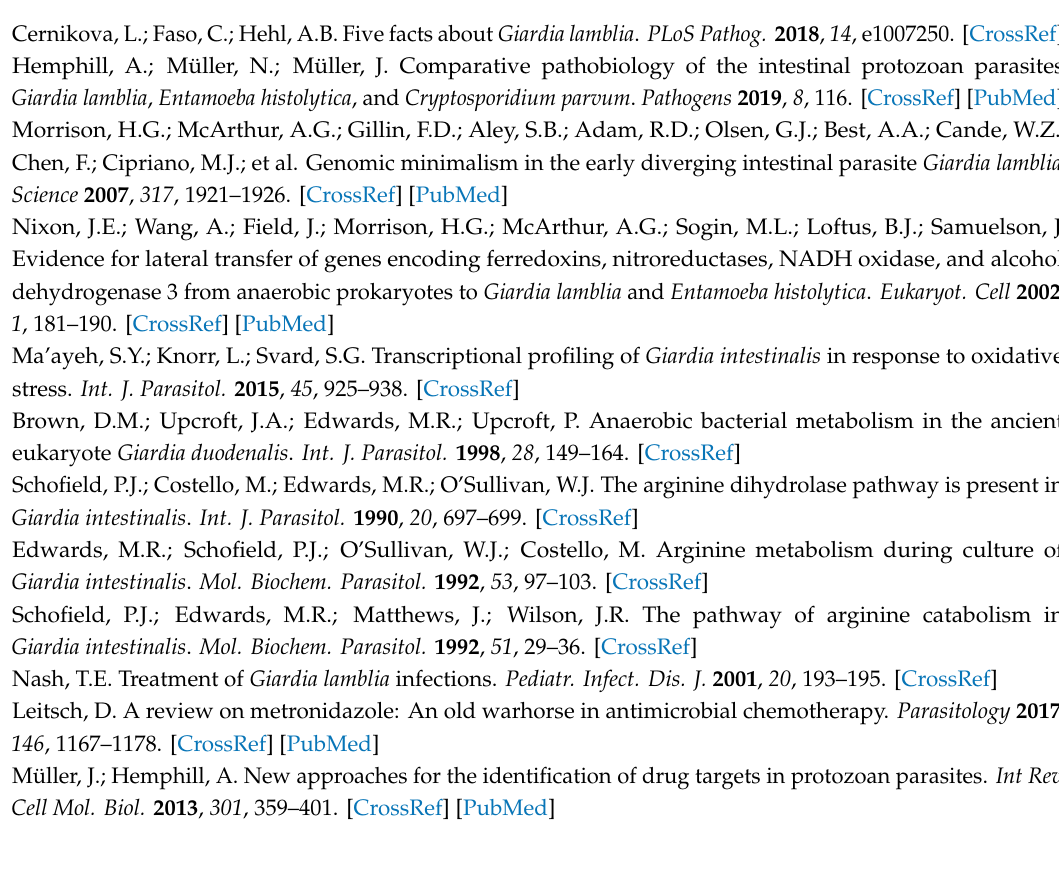
Figure S1: PCA and oPLS-DA of all integral regions (138 buckets) obtained by 1 H-HR-MAS NMR analysis of TrxR, TrxR DN, WT1, NR1, NR2, NR3, GusA, and WT2 trophozoites. The strains are detailed in Table 1. A, PCA; B, oPLS-DA, Figure S2: Metabolites identified in G. lamblia WBC6 wildtype trophozoites (WT, n = 4) and in trophozoites of the nitro drug-resistant strain C4 ( n = 10); mean values ± SD. Metabolites marked with ** and * were significantly di ff erent with p < 0.001 and p < 0.005 respectively according to t-test and correction for multiple comparisons. Significant levels in gray were excluded from discussion due to high variability between di ff erent WT-batches, Figure S3. Representative 1 H HR-MAS NMR spectra of Giardia trophozoites indicating selection of spectral regions / buckets and their metabolite assignments that were used for integration in univariate analysis. Ac (acetate) and Ile are better visible in the upper spectrum (A) than in the lower spectrum (A’). For metabolites marked with * the average of multiple regions as indicated were used. A-D, contiguous spectral regions; Cyn, cysteine, Table S1: Peak integrals obtained by 1 H-HR-MAS NMR analysis of G. lamblia WBC6 wildtype trophozoites (WT; two independent experiments), in trophozoites overexpressing thioredoxin reductase (TrxR) or a dominant negative mutation of TrxR (TrxR DN) as a control, and in trophozoites overexpressing the nitroreductases NR1, NR2, NR3, or GusA as a control, Table S2: Summary of parameters and statistical results of the oPLS-DA shown in Figures 2, 3 and 5. Table S3: Peak integrals obtained by 1 H-HR-MAS NMR analysis of G. lamblia WBC6 wildtype and nitro drug-resistant C4